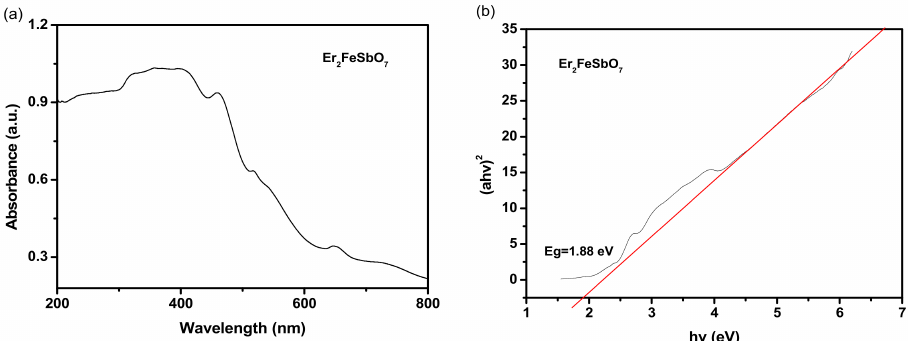
Figure 3. ( a ) UV-Vis diffuse reflectance spectra of Er 2 FeSbO 7 ; ( b ) Plot of ( α h ν ) 2 versus h ν for Er 2 FeSbO 7